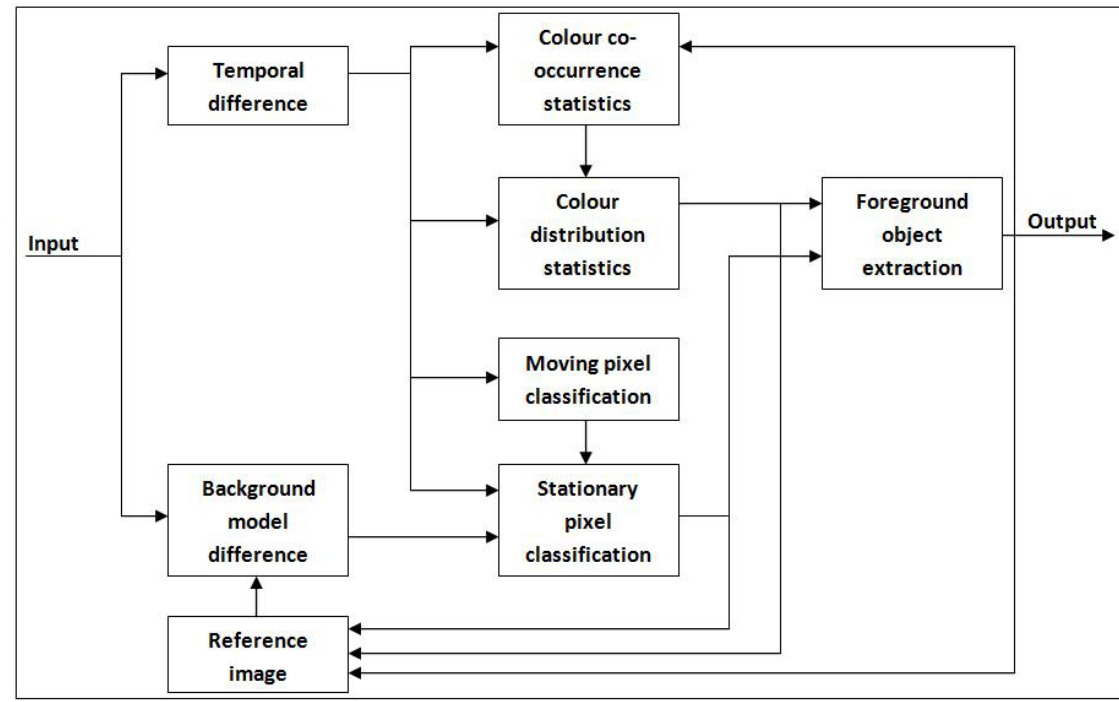
Figure 4. Block diagram of colour co-occurrence background